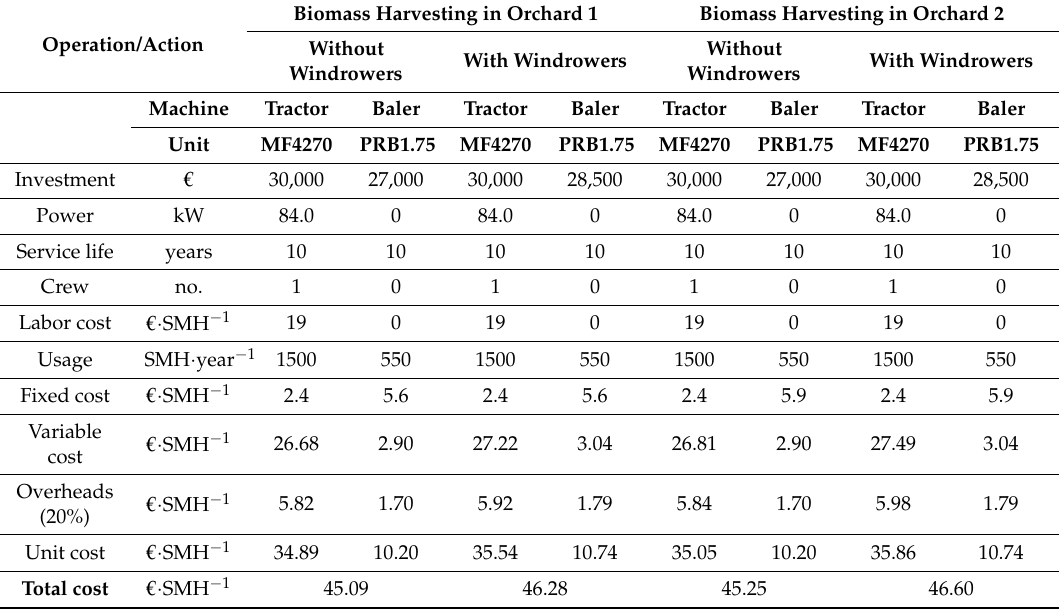
Table 1. Operation and maintenance costs for evaluated pruned biomass harvesting variants in the apple